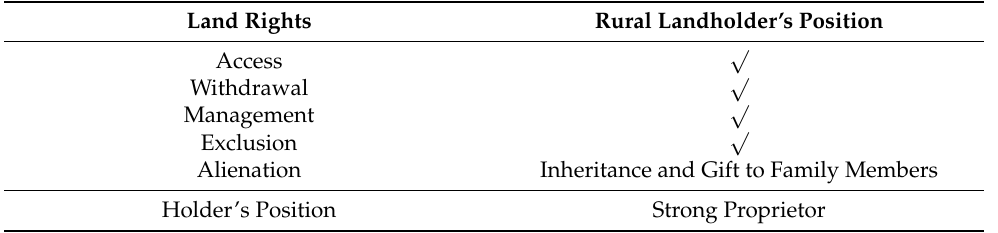
Table 2. Rural landholder